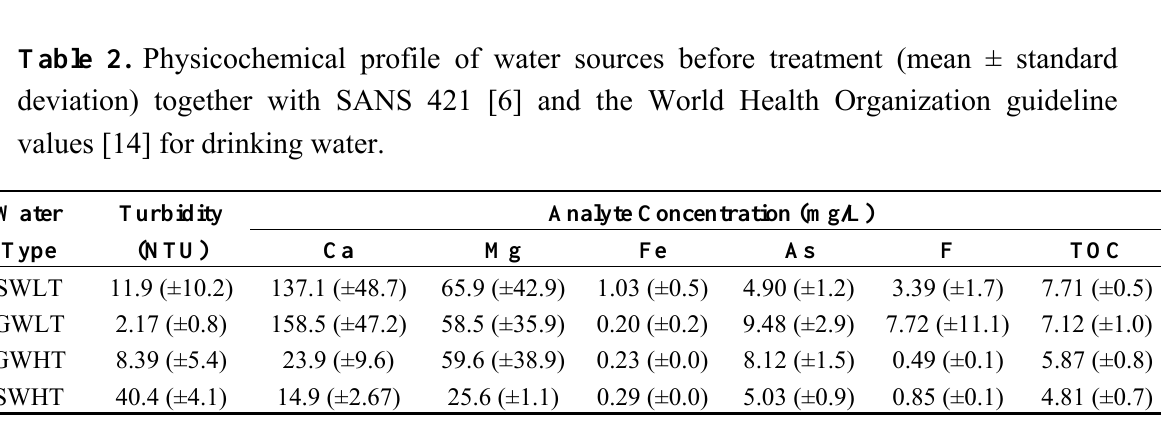
Table 3. Average reduction of contaminants by SIPP filter from different water